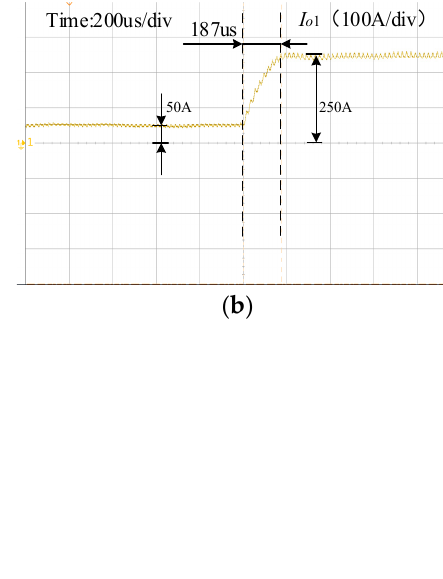
( b ) Figure 15. Steady state output waveform. ( a ) Dual DC currents ( b ) AC current. In the working state of the small-signal process, the duty cycle change will not be drastic. When the input voltage changes drastically, it can be quickly adjusted to the given current. As shown in Figure 16, compared with the traditional control system with PI reg- ulation only, the current system changes steadily and adjusts quickly. During welding, the stable current can keep the welding arc stable. Large- and small- signal control Traditional PID controlTime:200us/div Time:200us/div 125us I o （ 20A/div ） I o （ 20A/div ） 118us Figure 16. Small-signal control output waveform.